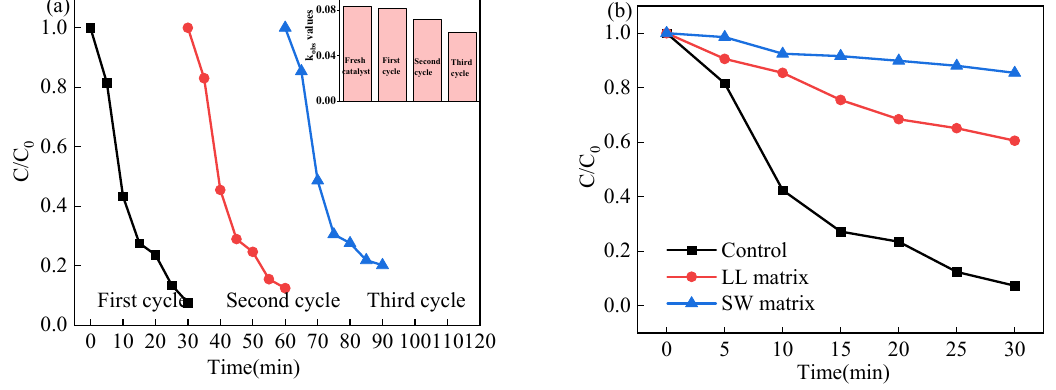
Figure 10. ( a ) Catalytic performance for three runs; ( b ) catalytic performance in different water ma- trix.